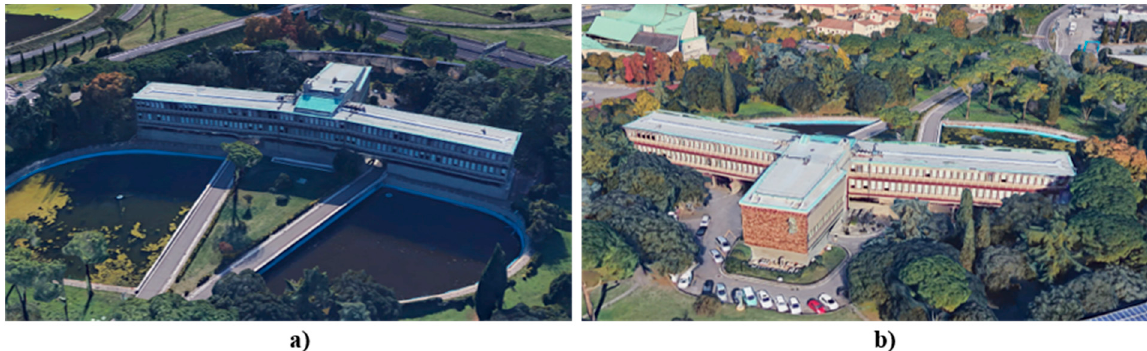
Figure 1. Views of the case-study building: ( a ) northern, and ( b ) southern.